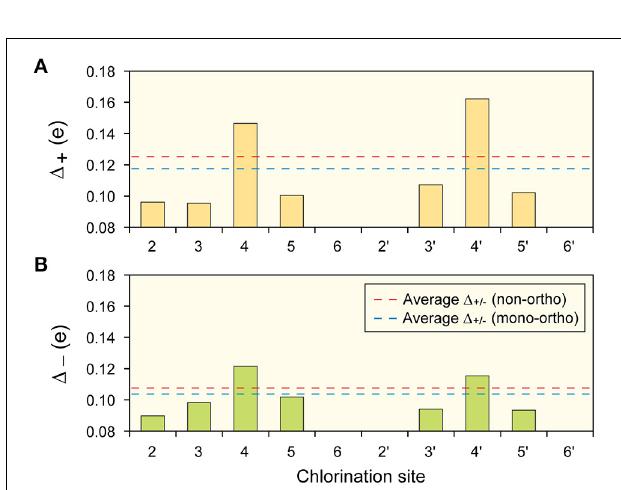
FIGURE 3 | Average site-specific reactivity of PCBs. Average site-specific reactivity for (A) giving up electron (B) taking electron for the 12 dioxin-like PCBs. Note the para (4 and 4 (cid:5) ) sites are most active, then meta (3, 3 (cid:5) , 5, 5 (cid:5) ) then ortho (2, 2 (cid:5) , 6, 6 (cid:5) ). Also indicated are the average activities of